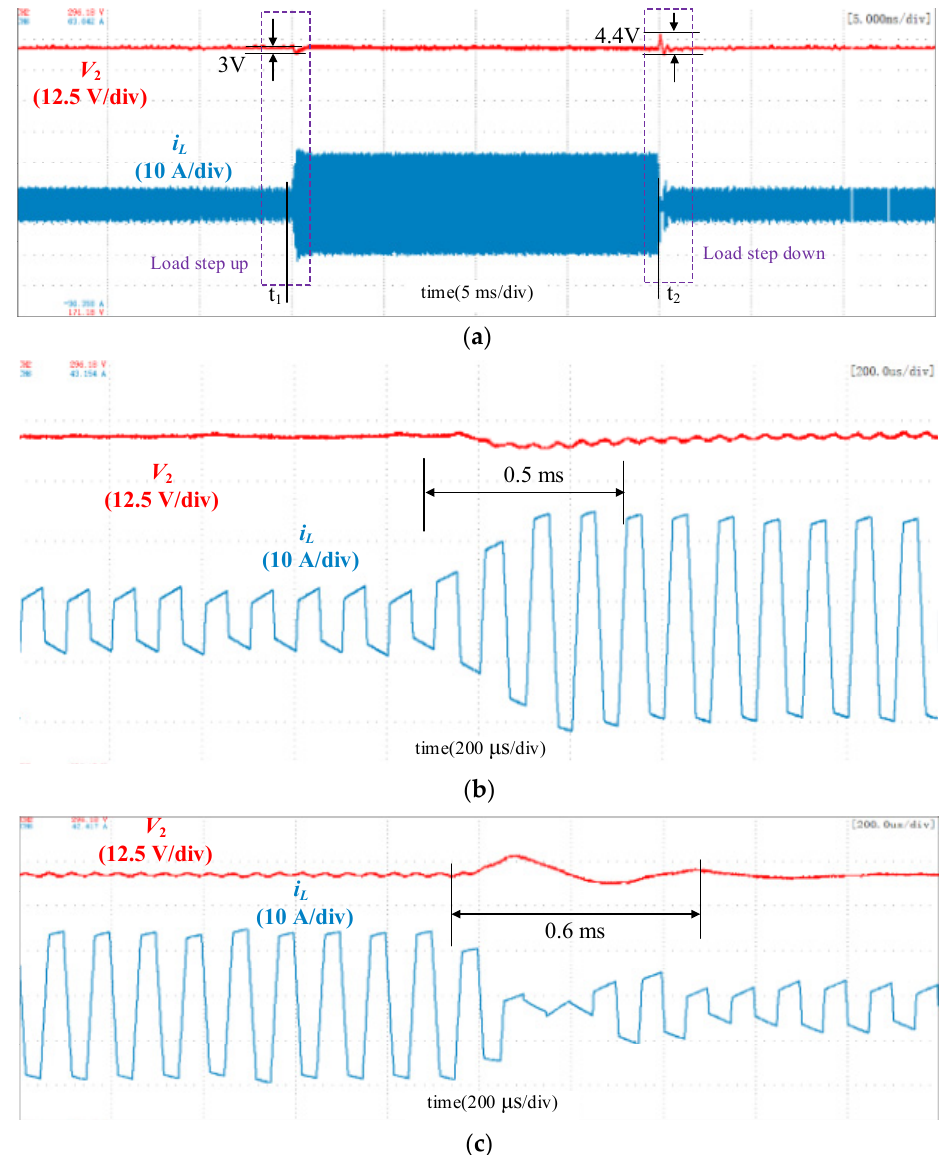
Figure 12. Waveforms using the double-closed-loop control with load feedforward. ( a ) Overall waveforms; ( b ) Zoomed-in waveforms during the load increase; ( c ) Zoomed-in waveforms during the load decrease.